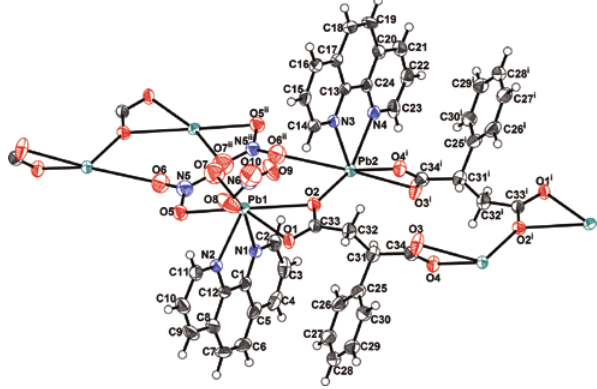
Figure 1: A view of the molecular structure of the complex. Symmetry codes: i: 2 − x , 3 − y , − z ; ii: 3 − x , 3 − y , 1 − z .